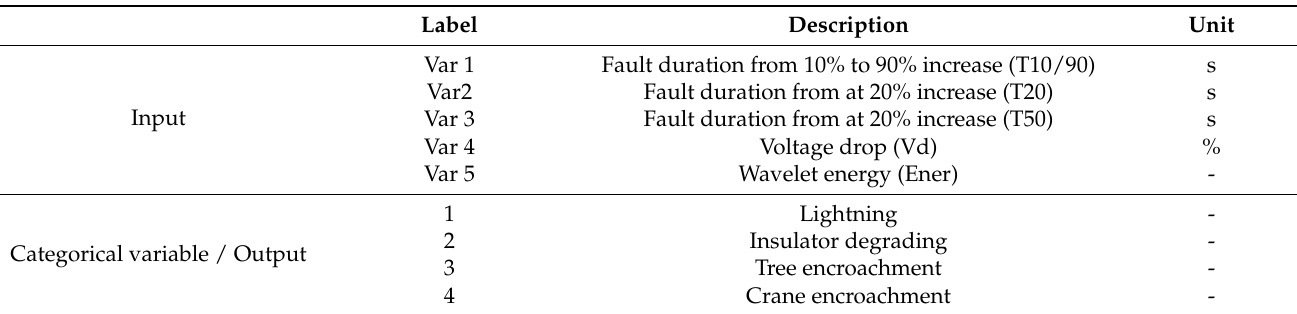
Table 6. Description for input and target output label.